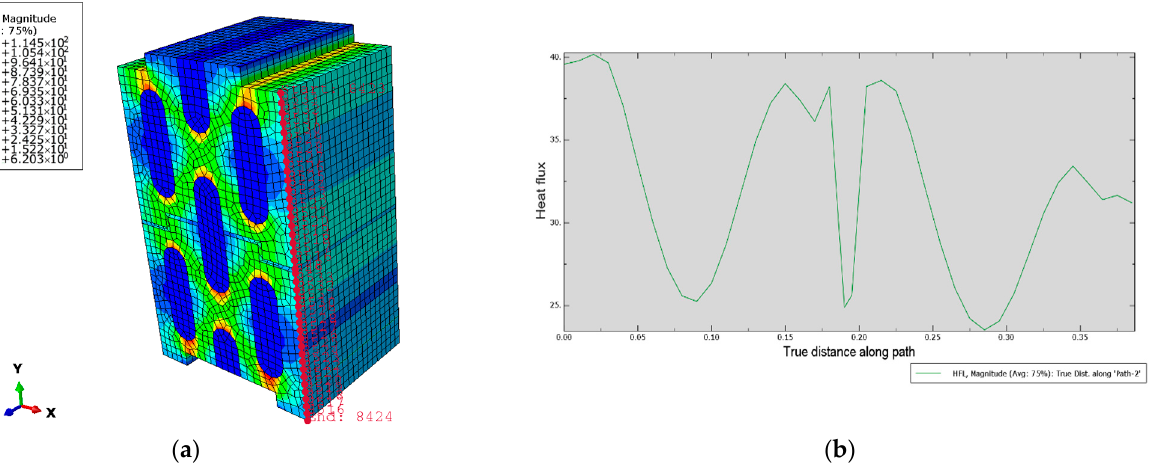
Figure 4. ( a ) Right calculation path in the 3D model; ( b ) heat flux (W·m − 2 ) of each node in the right path.